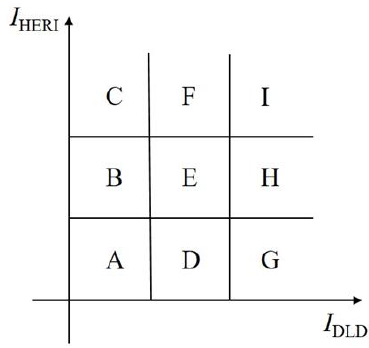
Figure 4. Schematic of the interval setting method of the relationships among the I HERI , I DLD , and landslide occurrence of each basic grid.